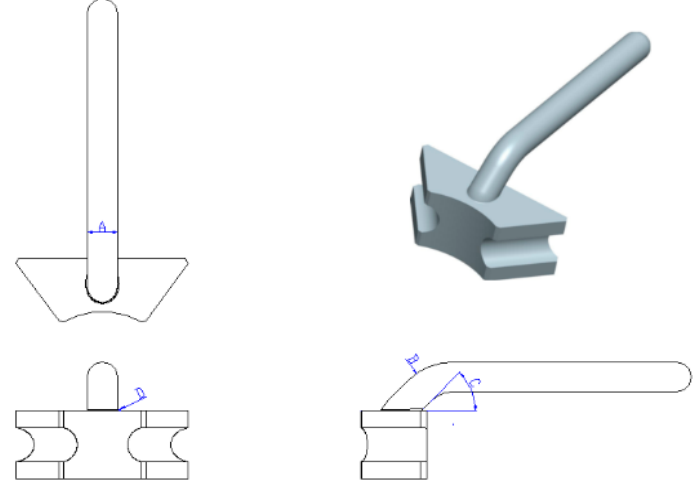
Figure 5. Size parameters of the new spanner.